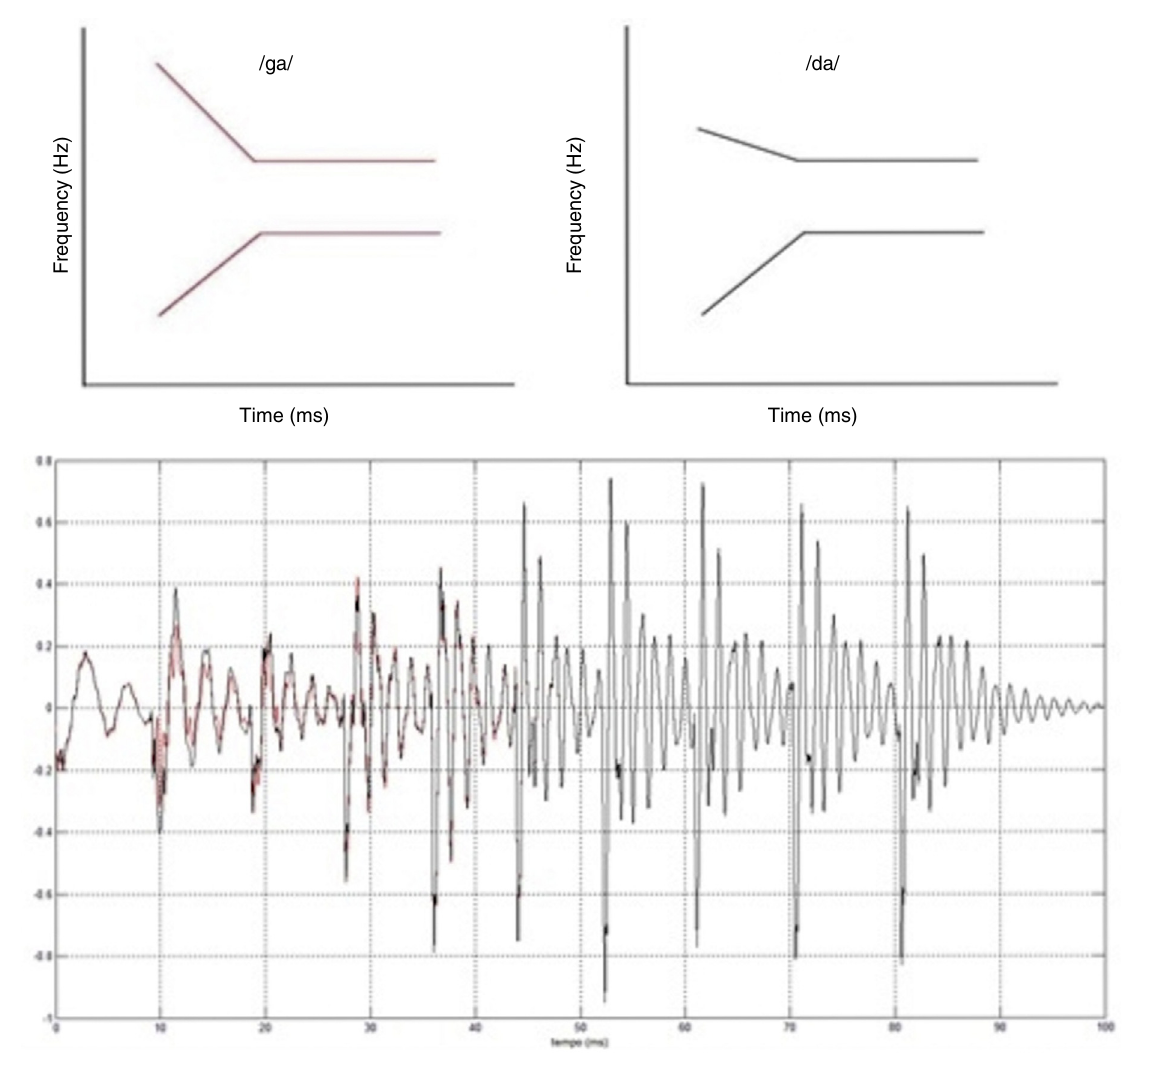
Schematic tracings of /da/ (black) and /ga/ (red) stimuli. Superimposed tracings showing the differentiation in formant onset.